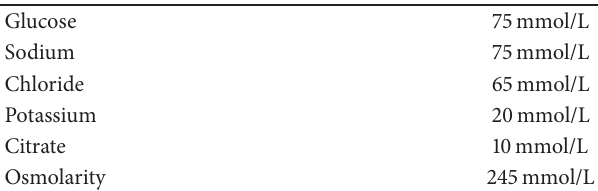
Table 1: Composition of oral rehydration salt solutions as defined in the 2009 WHO/UNICEF